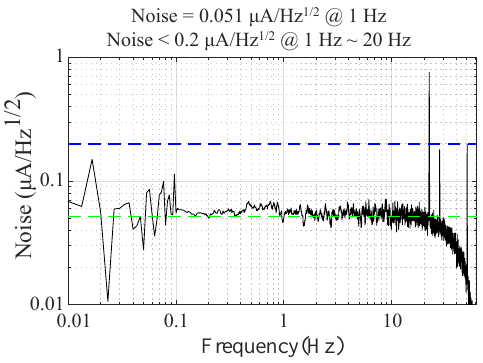
Figure 9. The noise power spectrum of the current source.